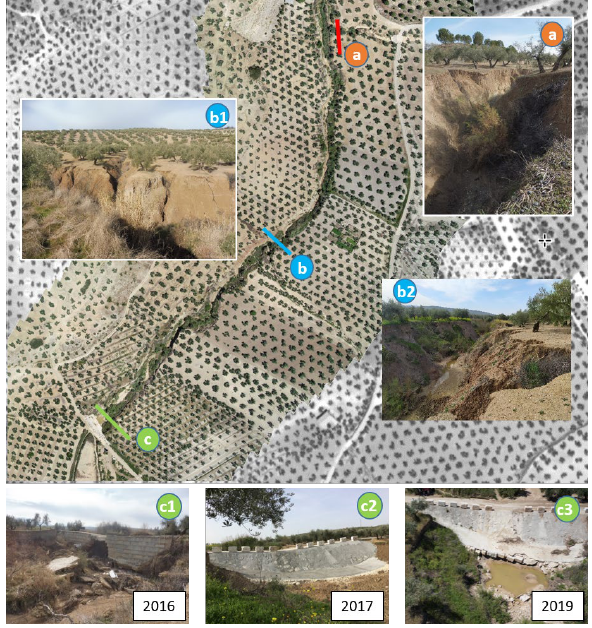
Figure 2. Photographs of different sectors of the gully area. (1a): V-shape of a section at a tributary gully. (b): Soil slab fall and landslides at the steep sidewalls. (c): Damages affecting a rural path due to upstream erosion. Background: Orthoimage of 2020 (in colour) and orthoimage of 2018 (in black and white). (Modified from Fernández et al., 2020